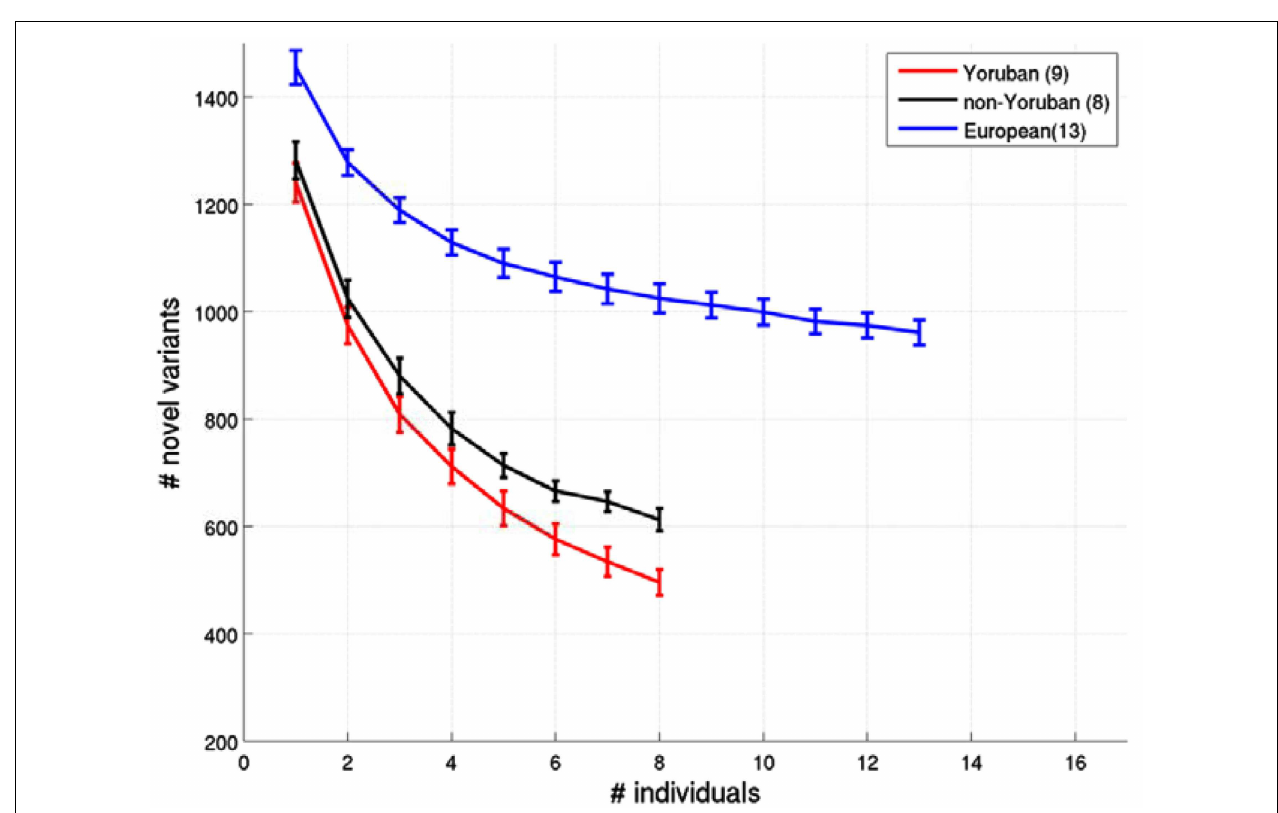
function of the number of individuals in the panel. Standard errors were computed by taking a randomly choosing the number of individuals from our collection of European, AfricanYoruban, or African non-Yoruban individuals given on the x